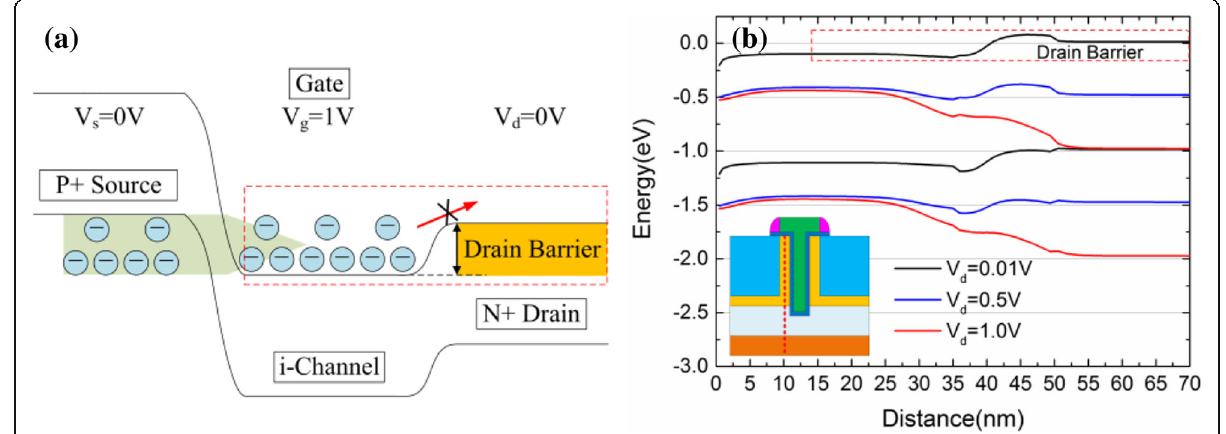
Fig. 12 a Schematic diagram of the energy band at V d = 0 V and V g = 1 V. b Simulation results of the energy band diagram at different biases of